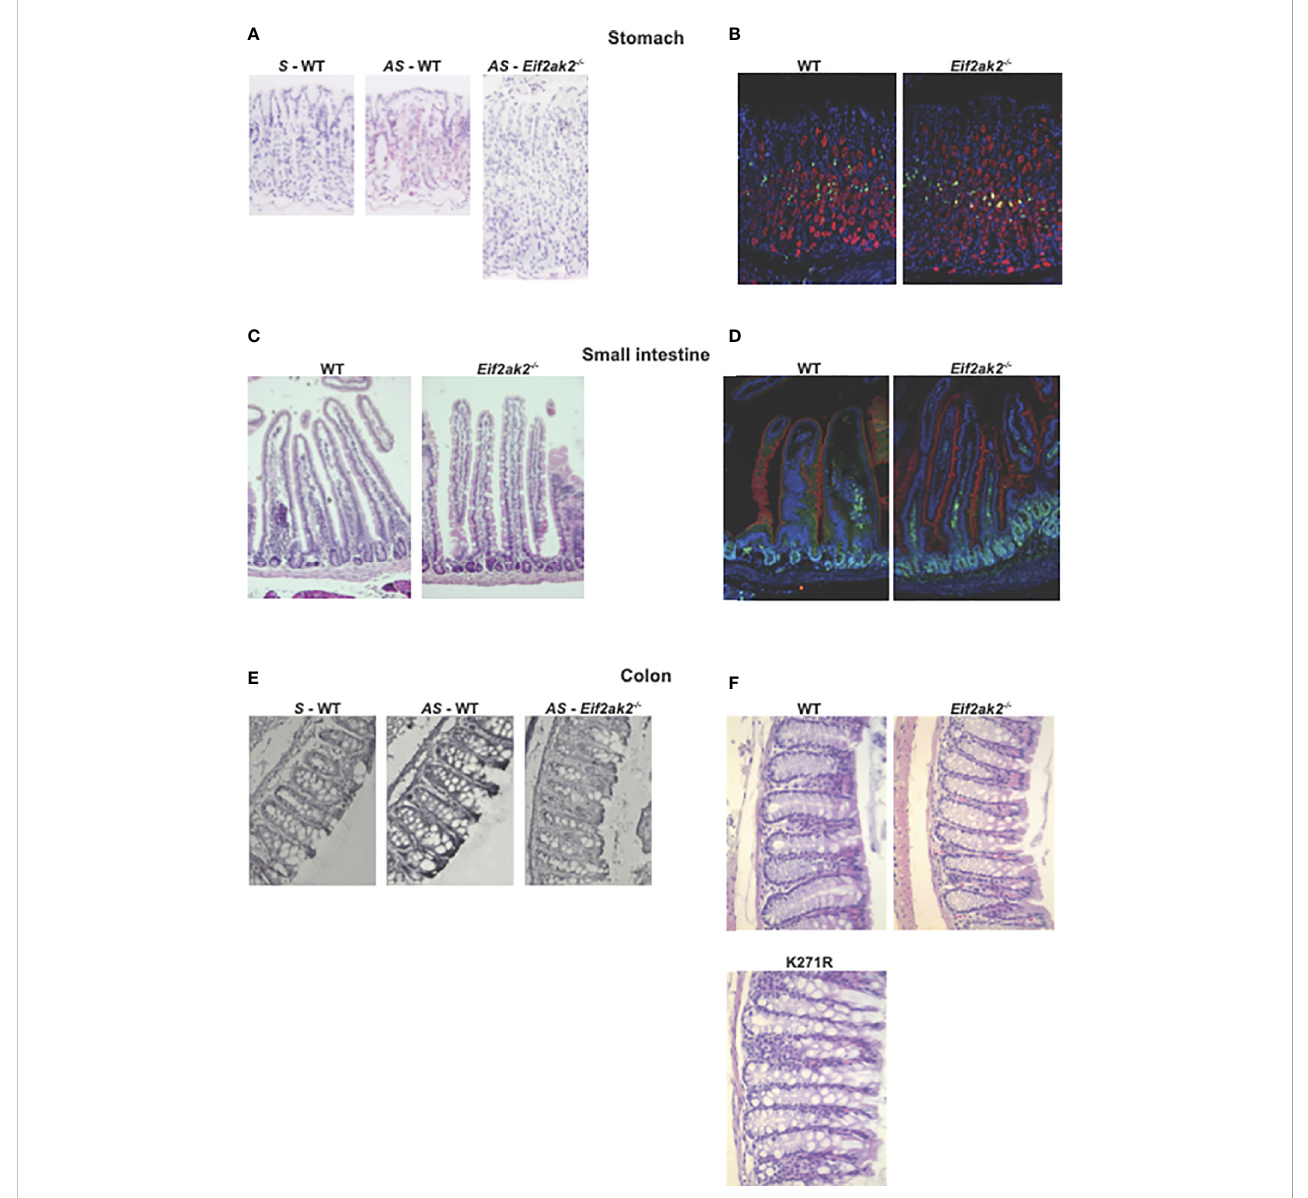
FIGURE 6 The effect of PKR on gastrointestinal physiology. (A – F) Micrographs of histologic specimens of the stomach, small intestine and colon from the indicated mice. (A) Tissue from the stomach probed with sense (S) and anti-sense (AS) oligonucleotides against the Eif2ak2 transcript, and (B) stained for proliferating cell nuclear antigen (PCNA, green) and H + /K – ATPase (red) to assess cell proliferation and the parietal cells in the stomach mucosa, respectively, and counterstained with Hoechst (blue) to detect cell nuclei. (C) Tissue from the small intestine stained with H&E or (D) fl uorescent probes against villin (red), to visualize microvilli at the brush boarder of the epithelial lining of the gut, PCNA (green) and Hoechst (blue). (E) Tissue from the colon probed with sense and anti-sense oligonucleotides against the Eif2ak2 transcript and (F) stained with H&E to visualize the tissue structure. Representative images are shown from three independent